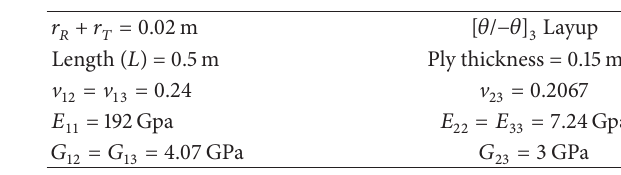
Figure 4: The influence of transverse shear deformation ( Ω = 100 rad/s). Table 1: Properties of the analyzed shaft.